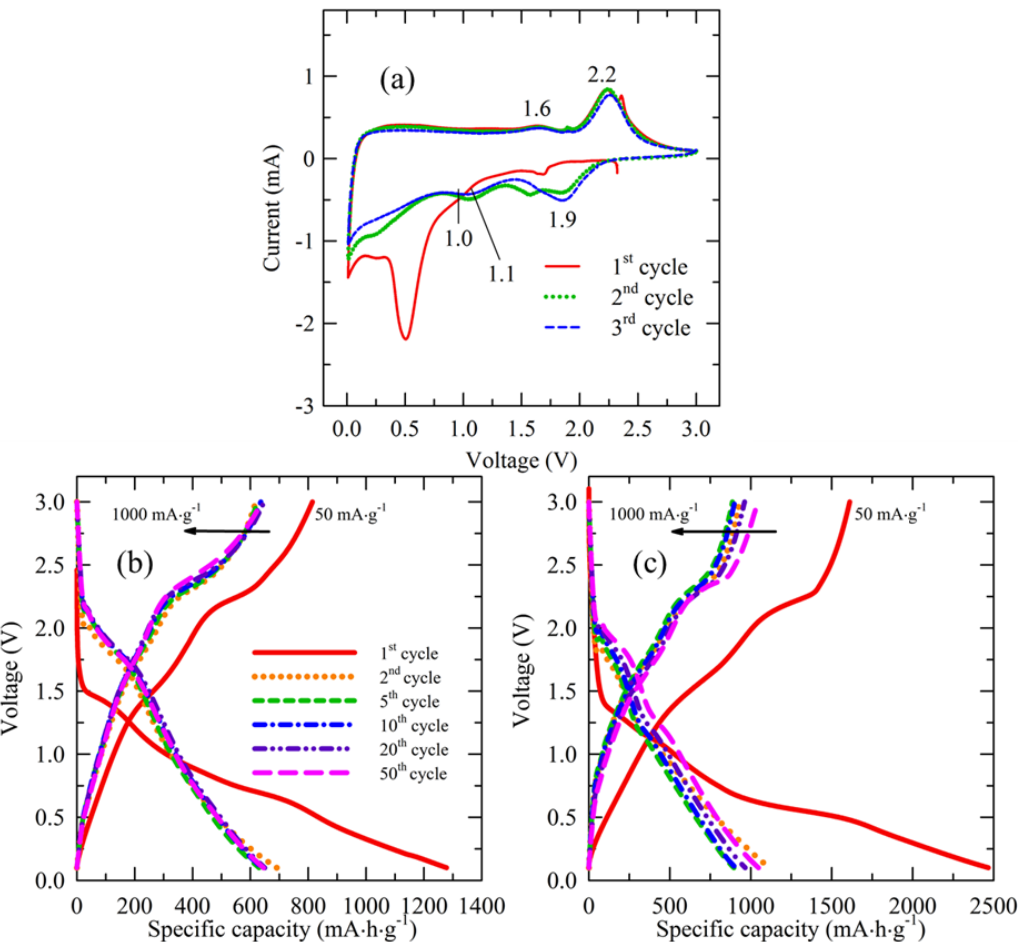
Figure 4. ( a ) Cyclic voltammogram curves in the voltage range 0.1–3.0 V at a scan rate of 0.5 mV · s − 1 of MS/CN for the first three cycles; galvanostatic discharge/charge profiles of ( b ) MS and ( c ) MS/CN for the first 50 cycles.